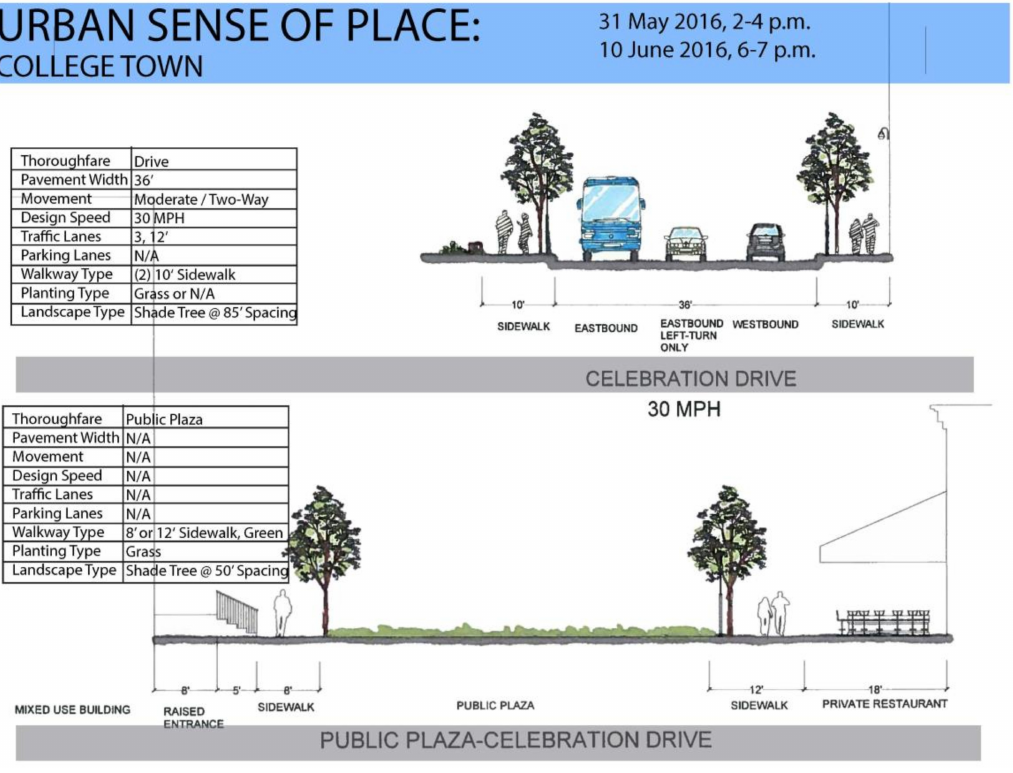
Figure 7. College Town street sections (by authors).